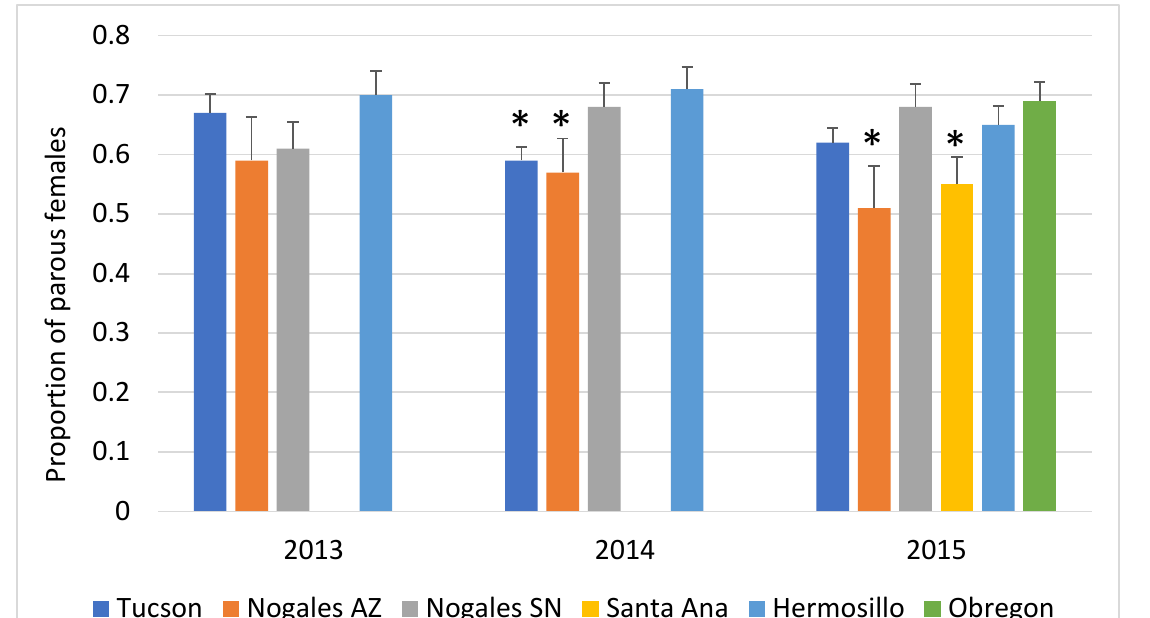
Figure 5. Proportion of parous mosquitoes by city and year. The asterisk * denotes cities with significantly different parity levels ( p < 0.05) than the reference city, Hermosillo (in light blue).